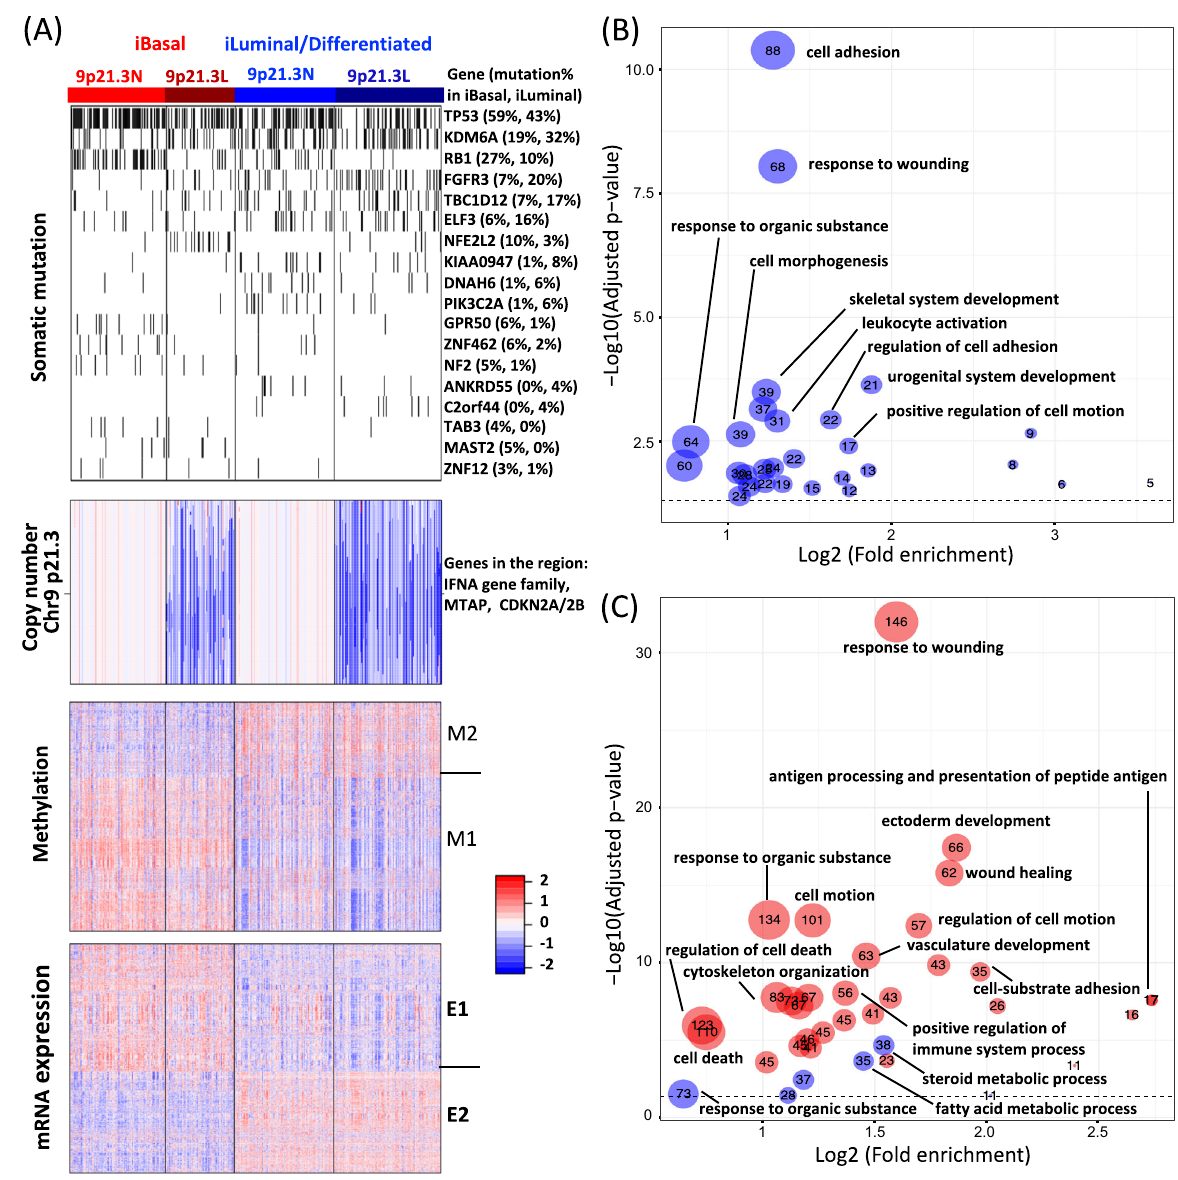
Fig. 1 Integrative subtypes of MIBC. a Heatmaps of driver genomic features. Somatic mutation : mutated and normal genes are represented by black and white colors, respectively. Copy number : red, white, and blue represent potential copy number gain, normal, and loss, respectively. Methylation : red and blue represent hypermethylation and hypomethylation, respectively; Driver genes were grouped into two clusters M1 and M2. mRNA : red and blue represent high and low expression, respectively. Driver genes were grouped into two clusters E1 and E2. b Top enriched biological processes in methylation cluster M2. c Top enriched biological processes in mRNA expression clusters E1 (red dots) and E2 (blue dots). The numbers of genes belonging to biological processes are shown in the